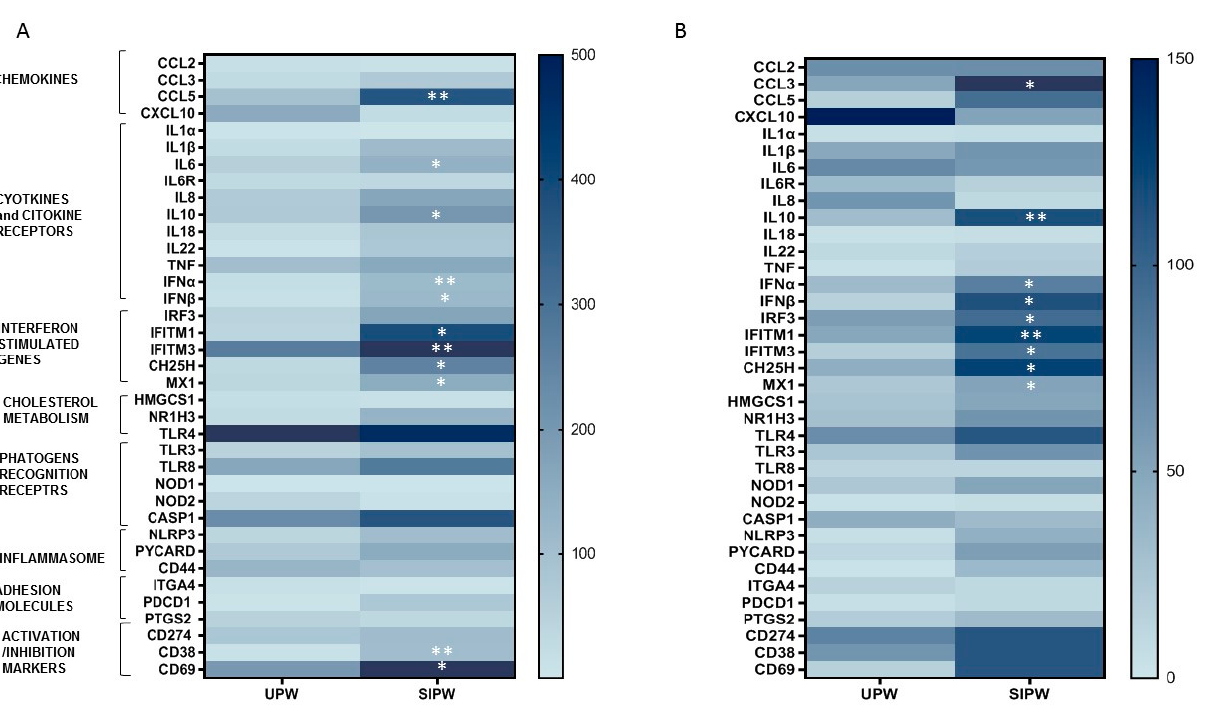
Figure 3. mRNA expression of genes involved in the antiviral/immune response. Quantigene Plex Gene expression technology was applied to quantify gene expression on RNA extracted from PBMCs ( A ) and placenta biopsies ( B ) isolated from 6 UPW and 15 SIPW. Gene expression (mean values) is shown as a color scale from light blue to blue (Heatmap). Only statistically significant p values from t-test comparison between UPW and SIPW are shown, as follows: * = p < 0.05 and ** = p < 0.01.